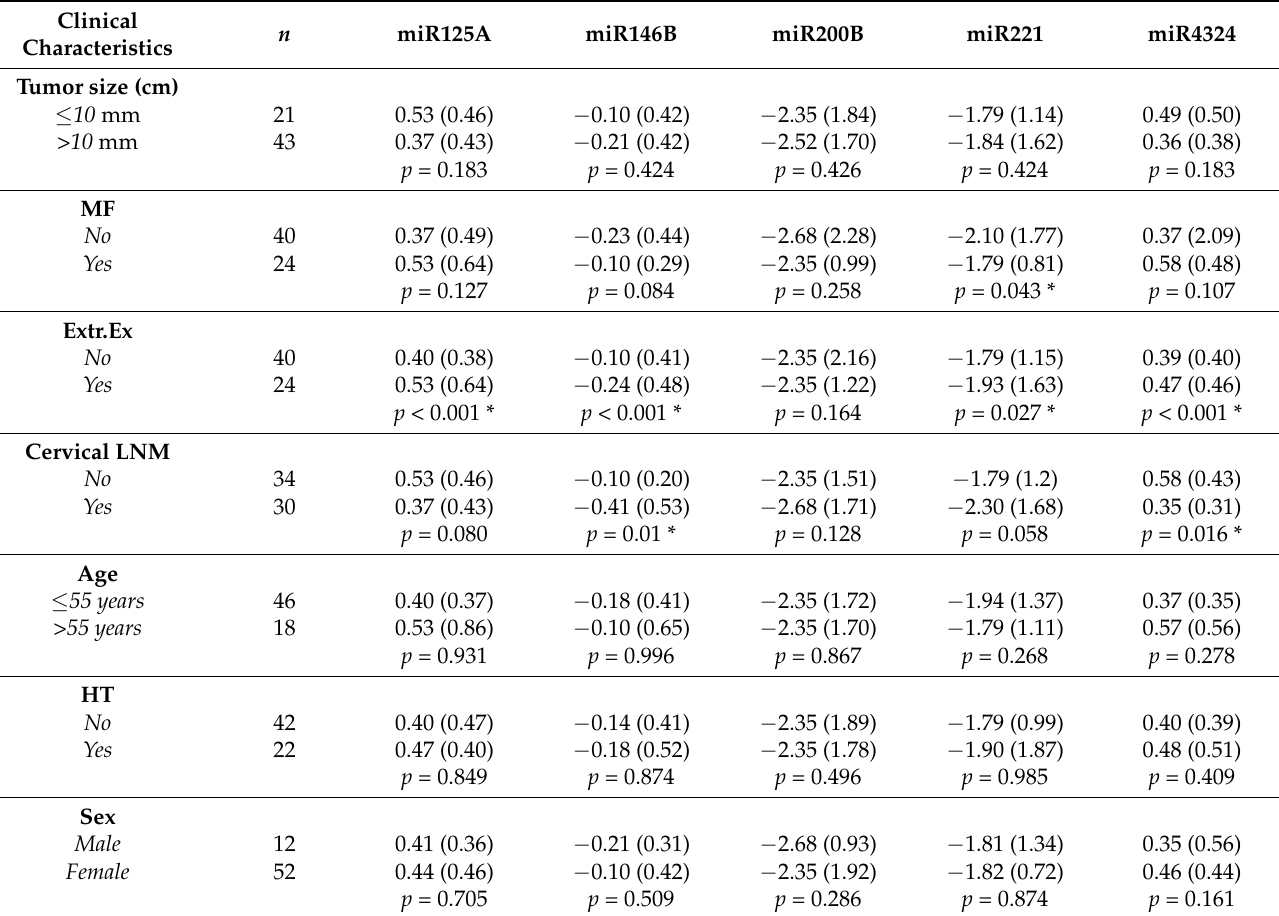
Table 3. Comparison of miRNA relative expression between clinical-demographic characteristics of